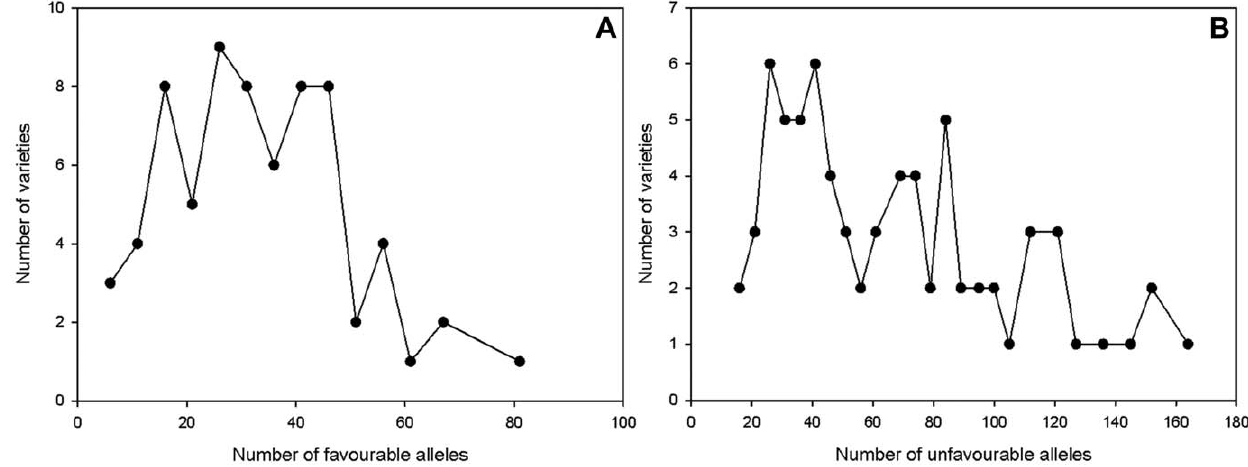
Figure 6. Frequency of (A) favourable FHB alleles and (B) unfavourable FHB alleles in individual varieties. Most varieties carried between 20 to 40 alleles increasing or decreasing the resistance to